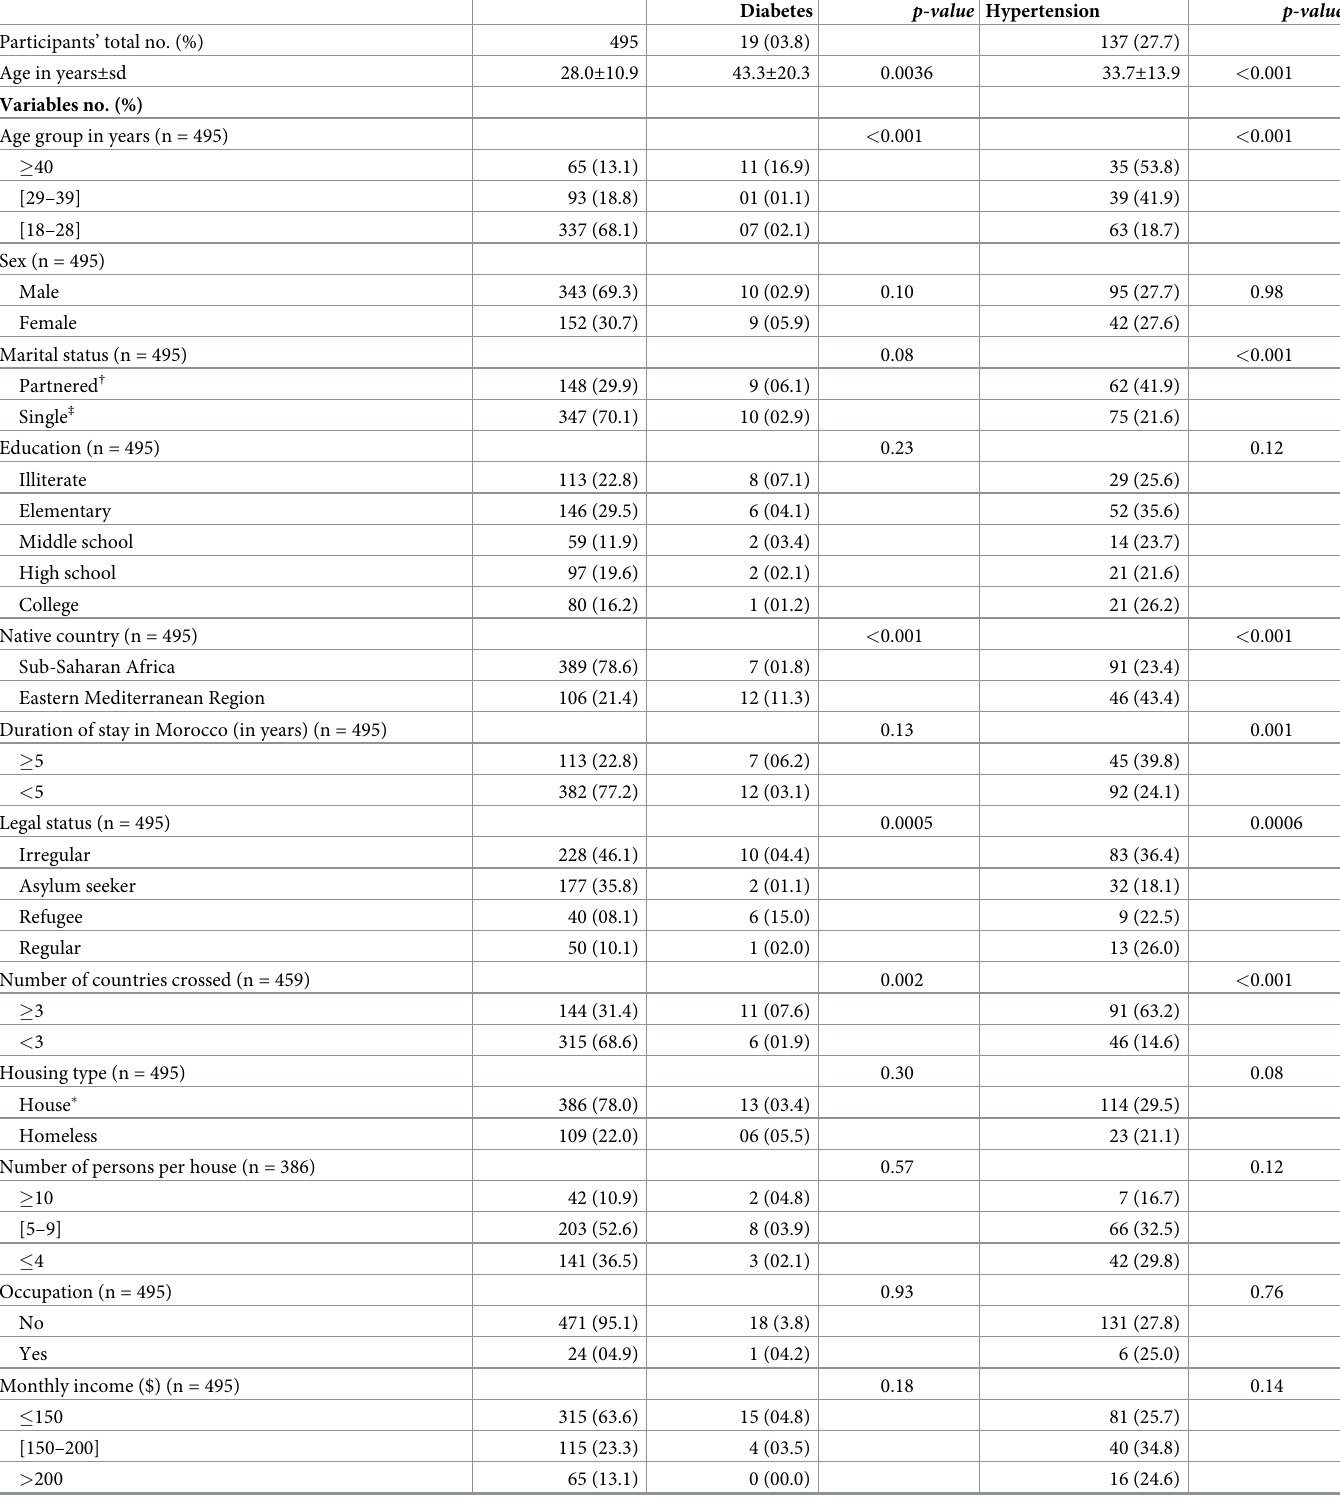
Table 1. The socio-economic and demographic characteristics of the migrant population in Oujda, Morocco, in 2021.